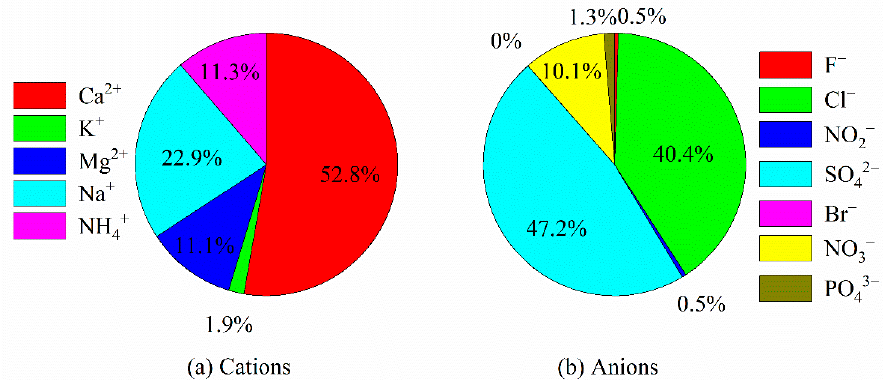
Figure 2. Comparison of the percentage of cations ( a ) and anions ( b ) based on equivalents.